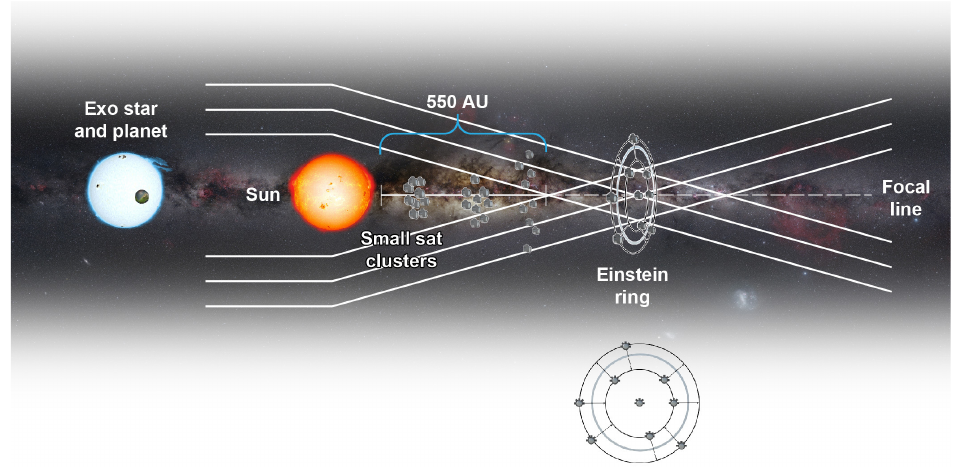
Figure 2. Clusters of small satellites in a string-of-pearls arrangement towards the Sun’s gravitational lens. Courtesy of and reprinted with permission of The Aerospace Corporation.